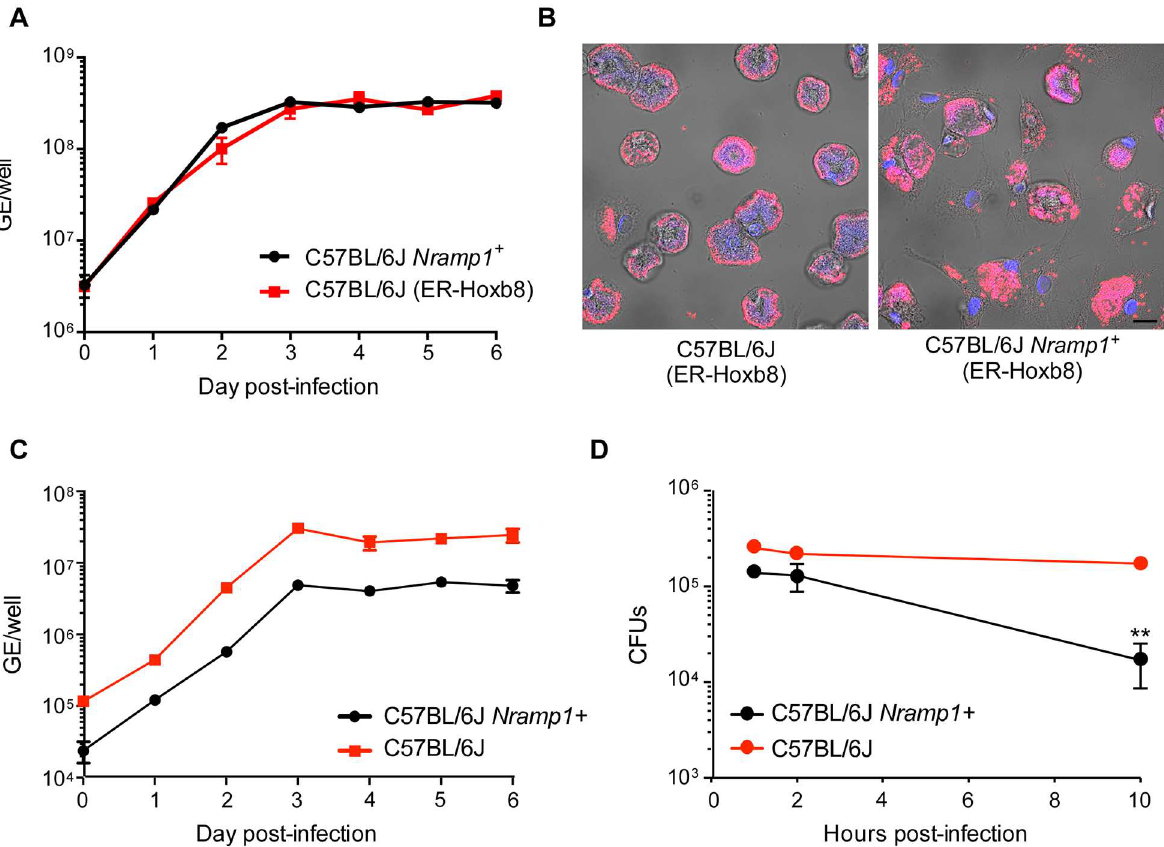
Fig 5. Wild type and Nramp1-positive ER-Hoxb8 macrophages are permissivefor NMII growth. (A) Bone marrow-derivedmyeloid progenitors from wild type and C57BL/6J Nramp1+ mice were immortalized with an estrogen-regulated Hoxb8 ( ER-Hoxb8 )oncogene. Macrophages were derived from immortalized progenitors using M-CSF and infected with NMII at an MOI of 10. Approximately 2 logs of NMII growth, basedon genomeequivalents(GE), was observedin both C57BL/6Jand C57BL/6JER-Hoxb8 Nramp1+ macrophages over a 6 day time course. Results are expressedas the means of three biologicalreplicatesfrom one experiment and are representative of two independent experiments. Error bars indicate the standarddeviations of the means. (B) Confocalfluorescence micrographs of ER-Hoxb8 micrographsshowinglarge vacuolesharboringNMII (red) in both cell types at 3 days post-infection. DNA is stainedwith DAPI (blue). Bar, 10 μ m. (C) Primary BMDM from wild type and C57BL/6J Nramp1+ mice differentiated with rmM-CSF were infected with NMII at an MOI of 0.1. Approximately 2 logs of NMII growth, basedon genome equivalents (GE), was achievedat early stationary phase(3 days post-infection) in both cell types. (D) Primary BMDM from wild type and C57BL/6J Nramp1+ mice differentiatedwith rmM-CSF were infected with Salmonella Typhimurium at an MOI of 5. Colonyforming units (CFUs), representingintracellular bacteria, were enumerated at 1, 2, and 10 h post-infection by platingmacrophagelysates on LB-agar plates. Significantly less CFU were recoveredfrom Nramp1+ macrophages then from wild type macrophages at 10 h post-infection (asterisks, p < 0.01). Results are expressedas the means of three biological replicates from one experiment and are representative of two independentexperiments. Error bars indicatethe standard deviations of the